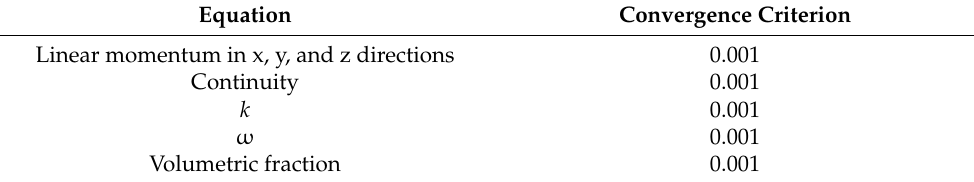
Table 4. Convergence criteria used. Equation